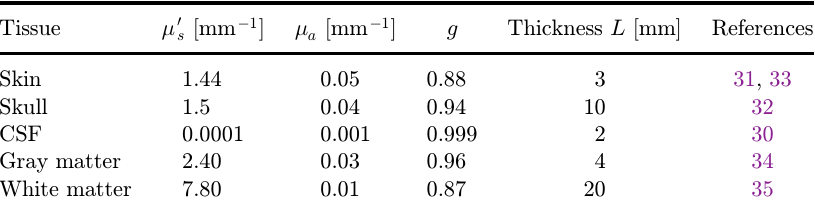
Table 1. Reduced scattering coe±cients, absorption, and thicknesses of head- mimicking phantom layers corresponding to real tissue layers at 915-nm